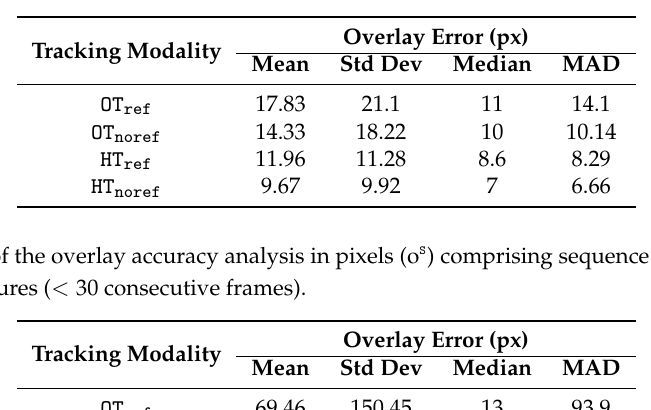
Table 1. Results of the overlay accuracy analysis in pixels (o S ) without tracking failures.